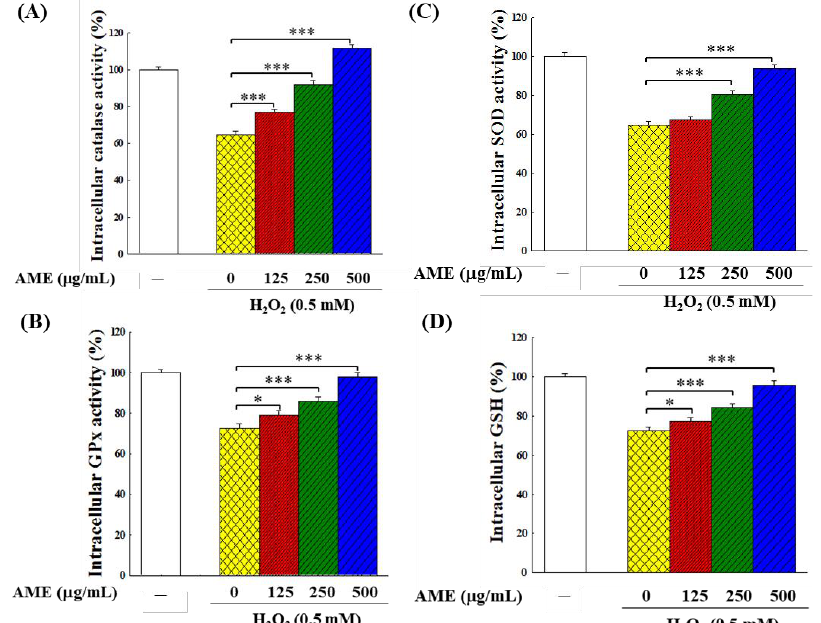
Figure 8. Effect of AME pretreatment on the antioxidant enzymes’ activities and the GSH content in H 2 O 2 -stimulated PC12 cells: ( A ) catalase, ( B ) GPx, ( C ) SOD and ( D ) GSH. The cells were first cultivated for 24 h, treated with AME at the indicated concentration for another 24 h, then stimulated with 0.5 mM H 2 O 2 for 4 h. The activities of catalase, GPx, SOD and the content of GSH were analyzed. This experiment was repeated five times. The significance of the difference in data compared to the vehicle (group 0) are labeled as * p < 0.05 and *** p < 0.001.